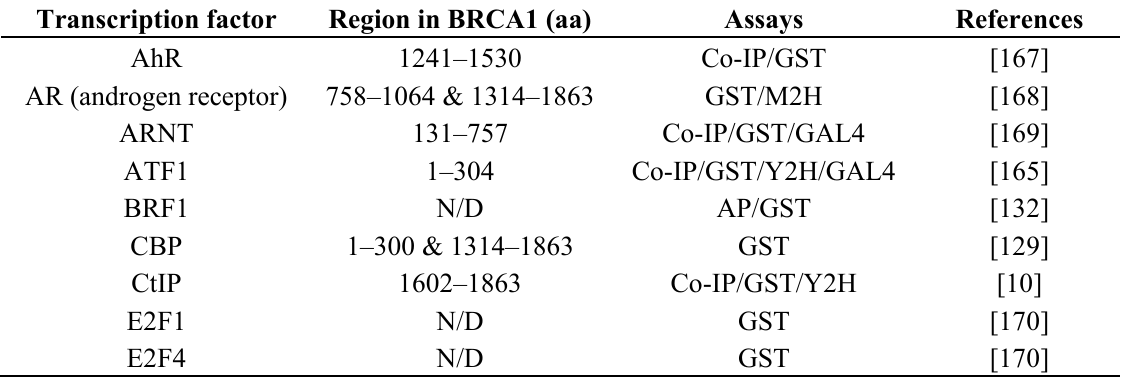
Table 1. Transcription factors that bind to